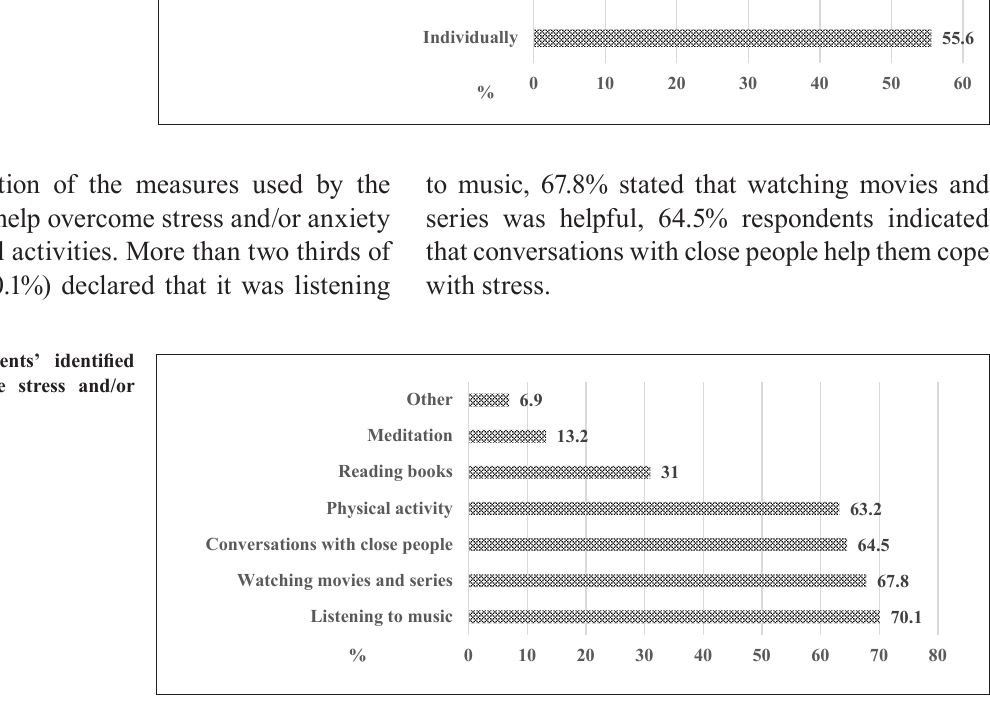
Figure 4. Nature of respondents’ physical activity during the quarantine period